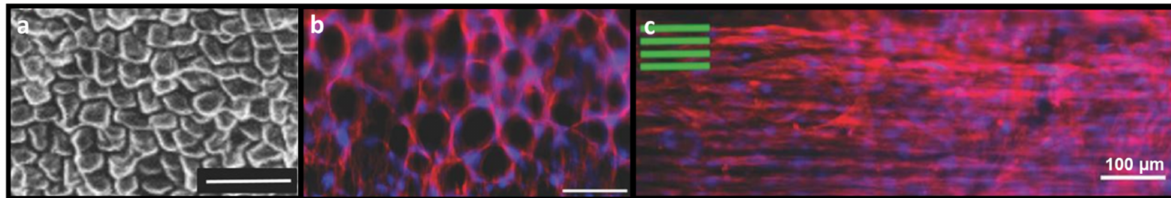
Figure 9. ( a , b ) Fibroblast cells pattern themselves around the topography of the stem of a queen anthurium. Reproduced from Fontana et al. [35]. ( c ) Cells align horizontally along pattern found in a wasabi plant stem. Reproduced from Fontana et al.